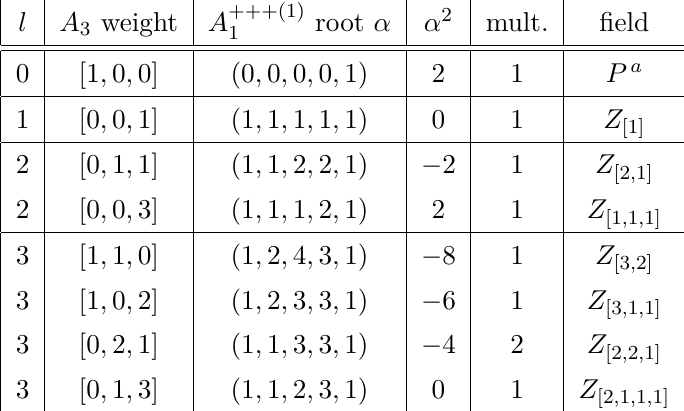
Table 4 . The ‘ 1 representation of A +++